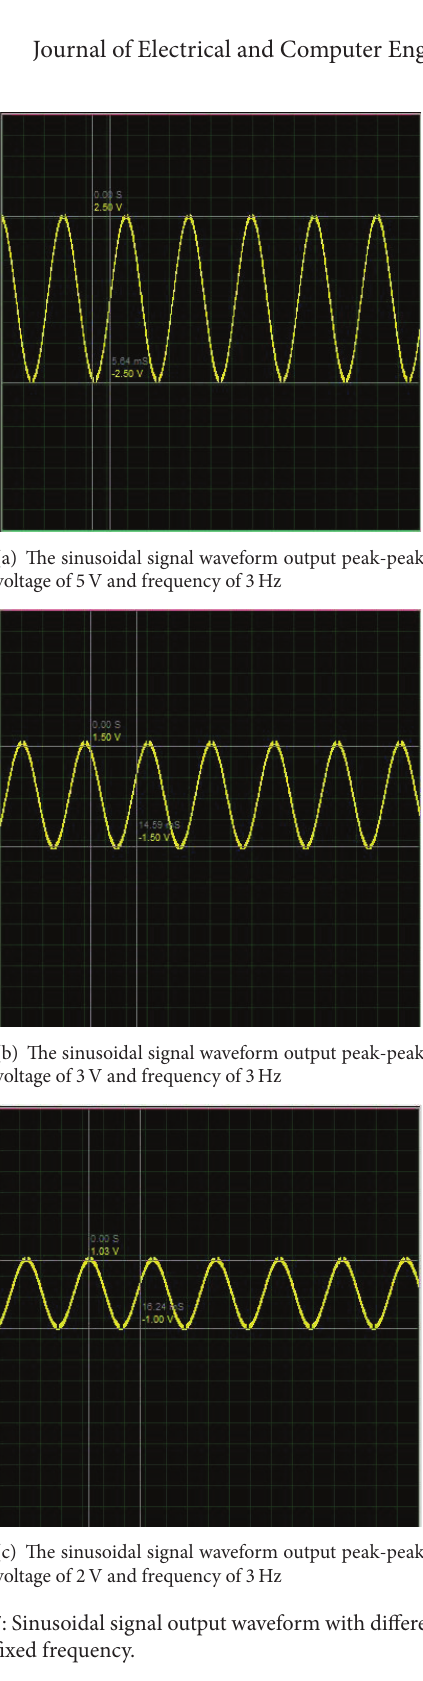
Figure 27: Sinusoidal signal output waveform with different ampli- tude and fixed